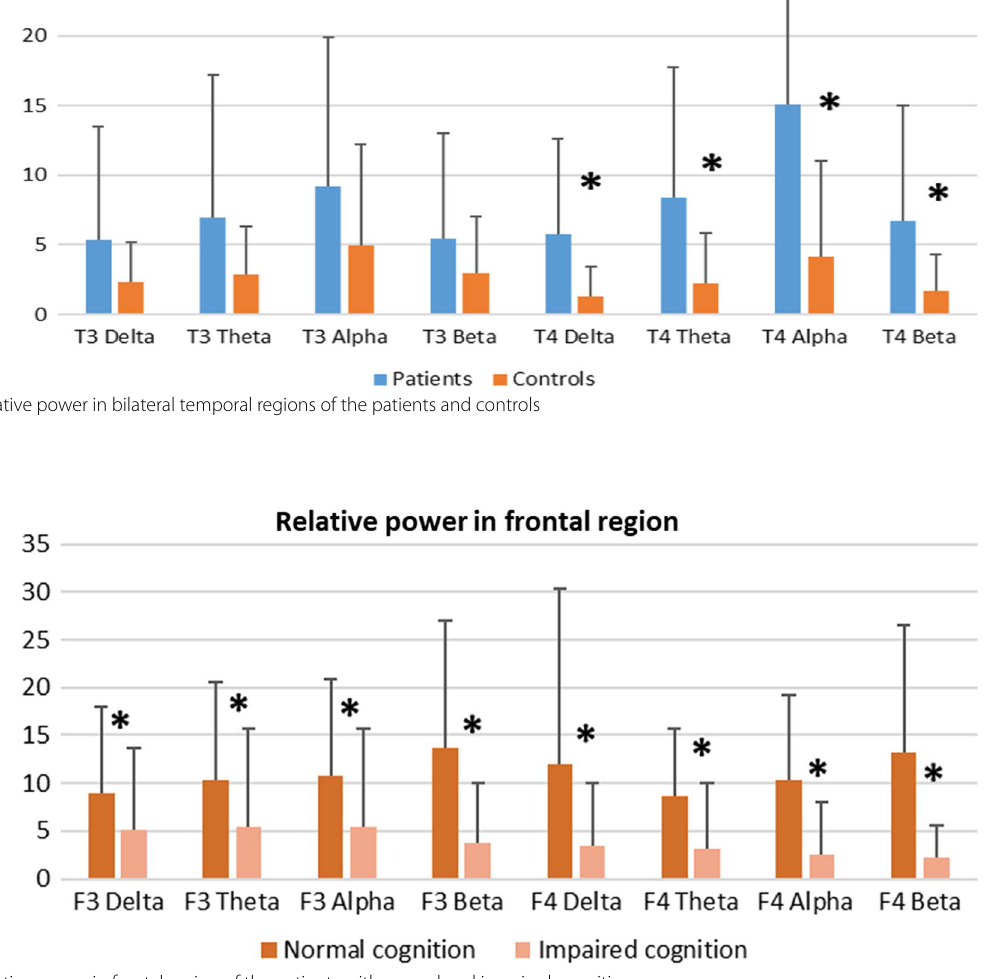
Fig. 2 Relative power in frontal region of the patients with normal and impaired